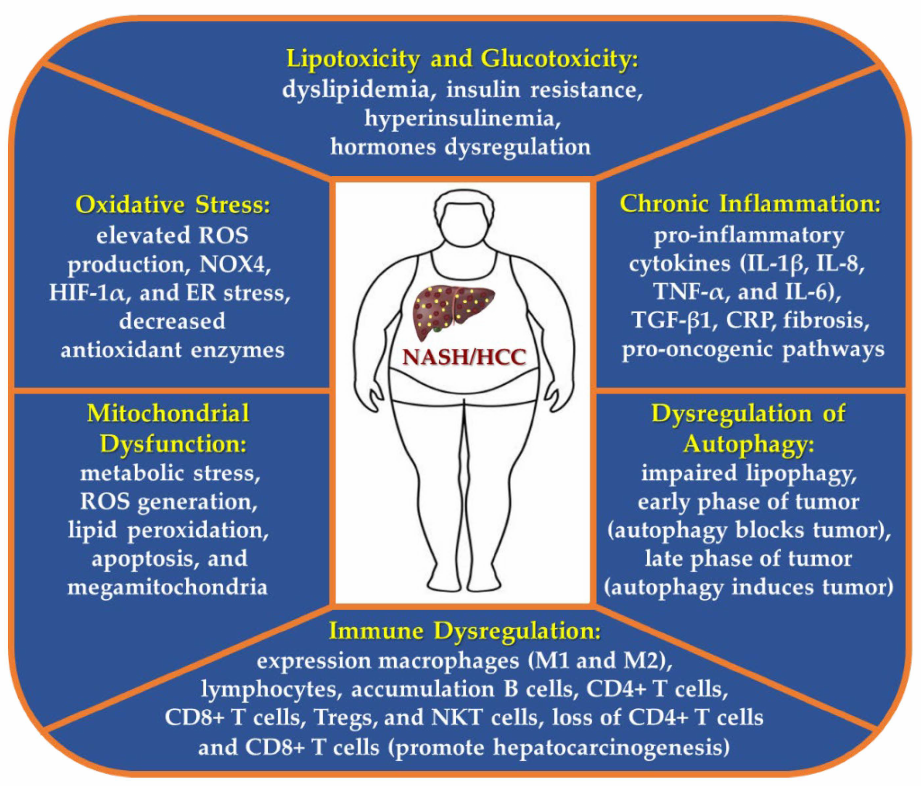
Figure 2. Pathogenic processes implicated in the onset and development of NASH-related HCC. Hyperlipidemia and hyperglycemia caused by obesity, promote insulin resistance and hormones dysregulation, which are responsible to trigger oxidative stress, inflammation, mitochondrial dysfunc- tion, as well as dysregulation of autophagy and immune function, leading to NASH and ultimately HCC. Abbreviations: CRP, C-reactive protein; ER, endoplasmic reticulum; HIF-1 α , hypoxia-inducible factor 1 alpha; NKT, natural killer T; NOX4, nicotinamide adenine dinucleotide phosphate reduced (NADPH) oxidase 4; ROS, reactive oxygen species; Tregs, regulatory T